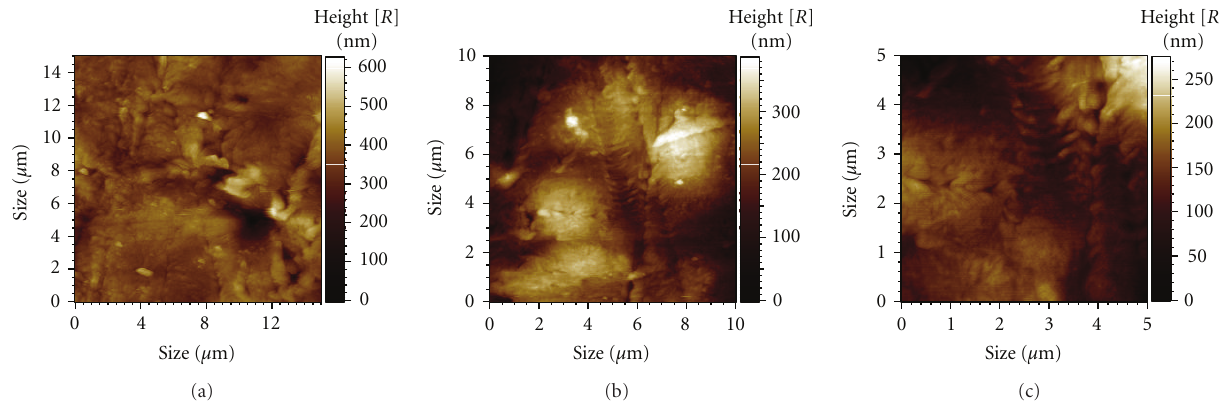
Figure 6: 3D images of the sca ff olds surface topography obtained with AFM. (a) area 1; (b) area 2; (c) area 3.